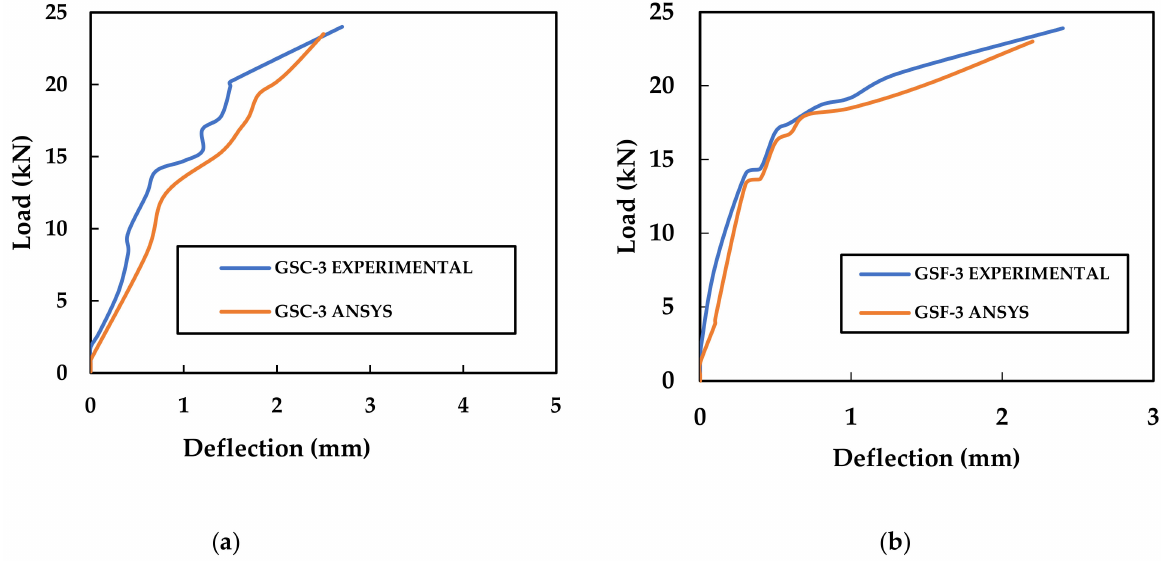
Figure 23. Comparison between experimental and numerical load–deflection behaviour of ( a ) GSC-3 and ( b )